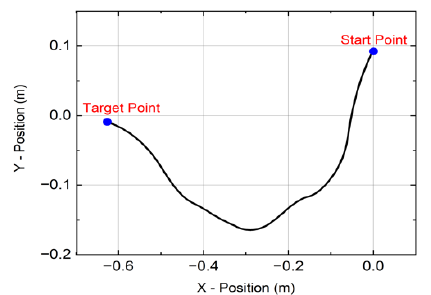
Figure 10. Mobile robot trajectory to the target object using a DQN agent.